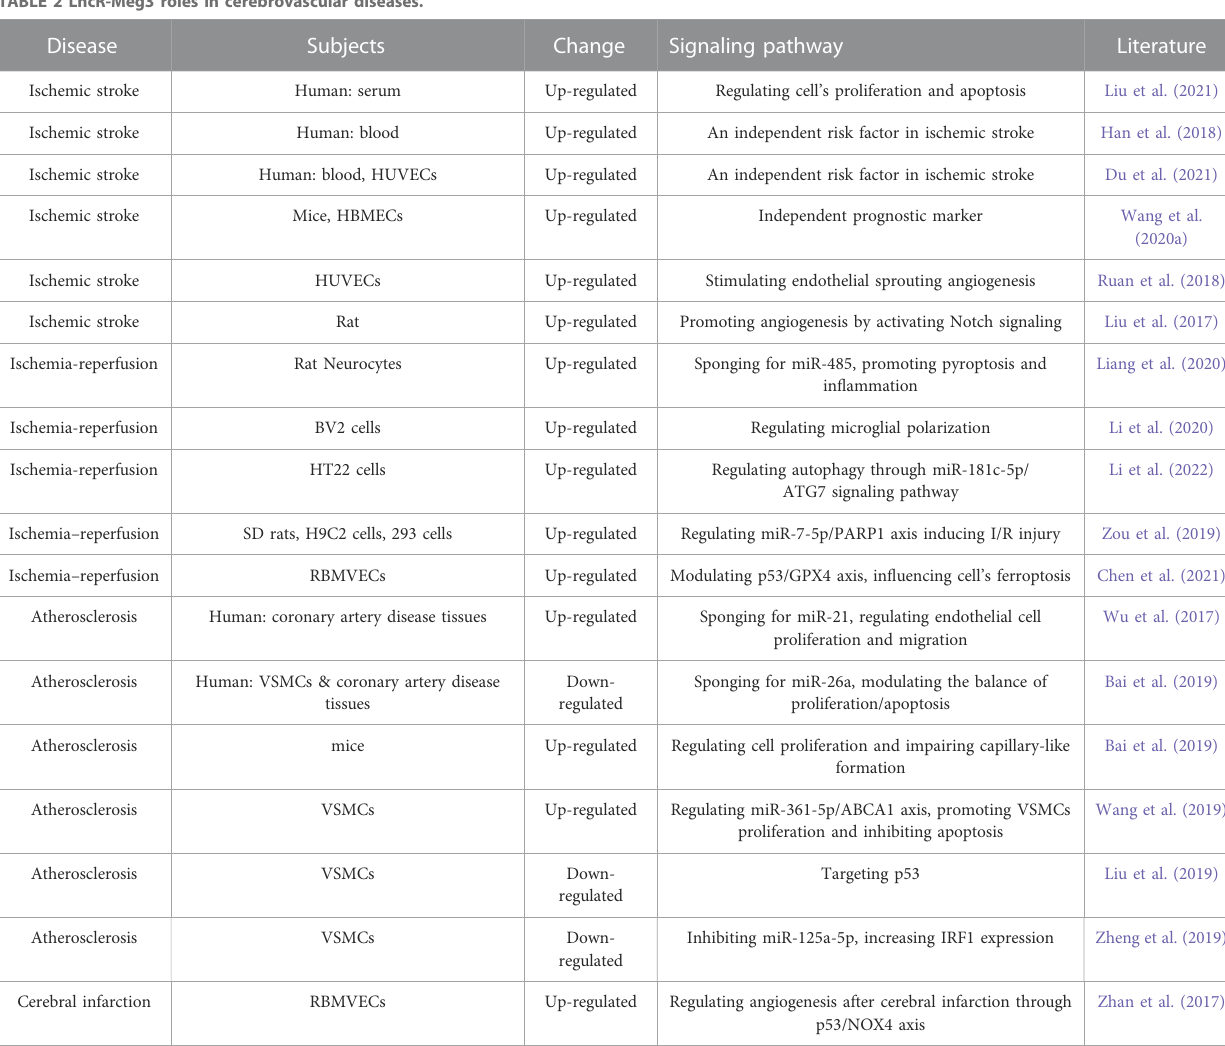
TABLE 2 LncR-Meg3 roles in cerebrovascular